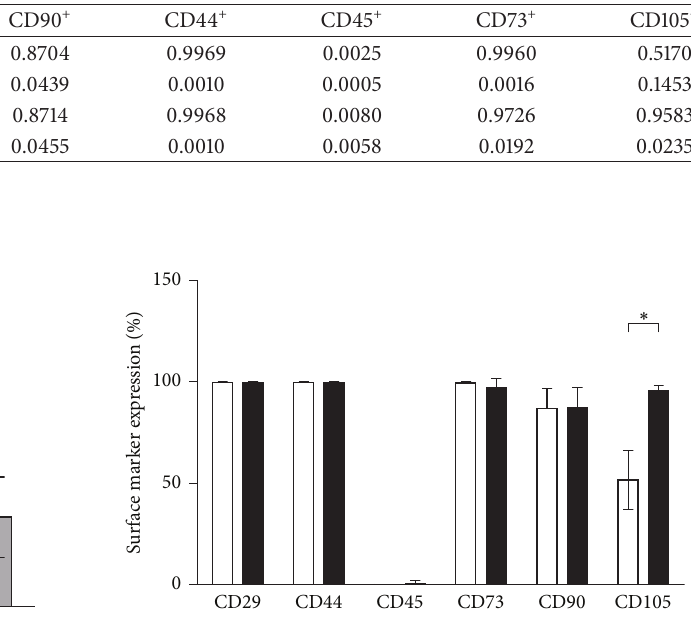
Table 2: Human MSC surface marker expression.